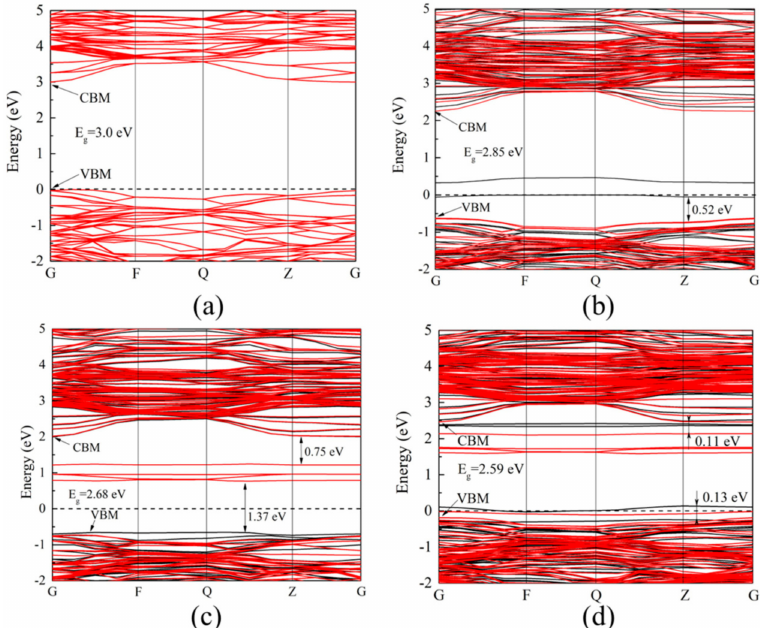
Figure 6. The band structures of ( a ) TiO 2 , ( b ) V–TiO 2 , ( c ) Co–TiO 2 , and ( d ) (V,Co)–TiO 2